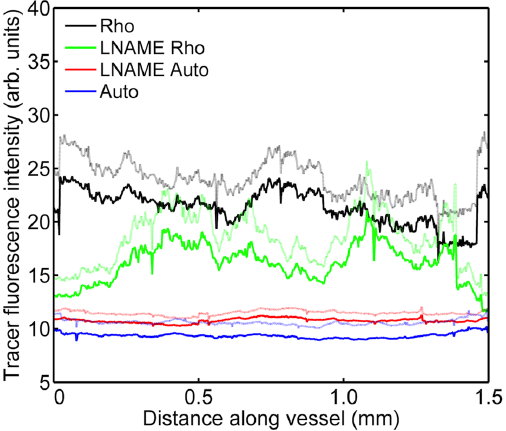
Fig. 12. Effect of L-NAME on tracer uptake along vessels in uncuffed mice. Fluorescence intensity along the length of carotid arteries of mice without cuffs; data from left and right carotids have been combined. Mice were administered the rhodamine-labelled tracer with (‘‘LNAME Rho’’) or without (‘‘Rho’’) the NO synthase inhibitor L-NAME. Autofluorescence was assessed in mice not administered the tracer, again with (‘‘LNAME Auto’’) or without (‘‘Auto’’) the inhibitor. Mean (dark lines) + 1 SEM (light lines), n 5 3-4 per